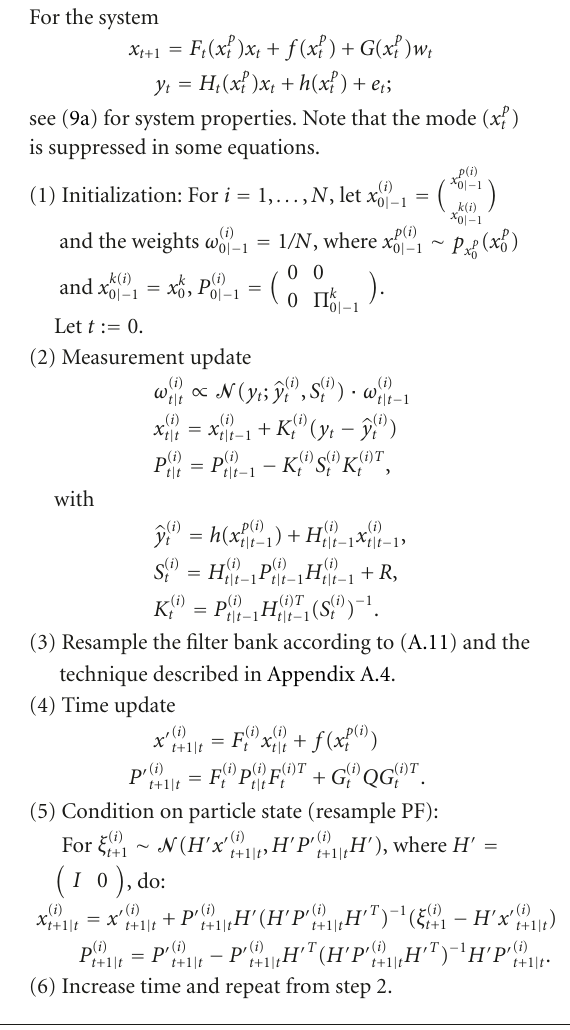
Algorithm 2: Filter bank formulation of the RBPF, where x represents the equivalent of a mode parameter.